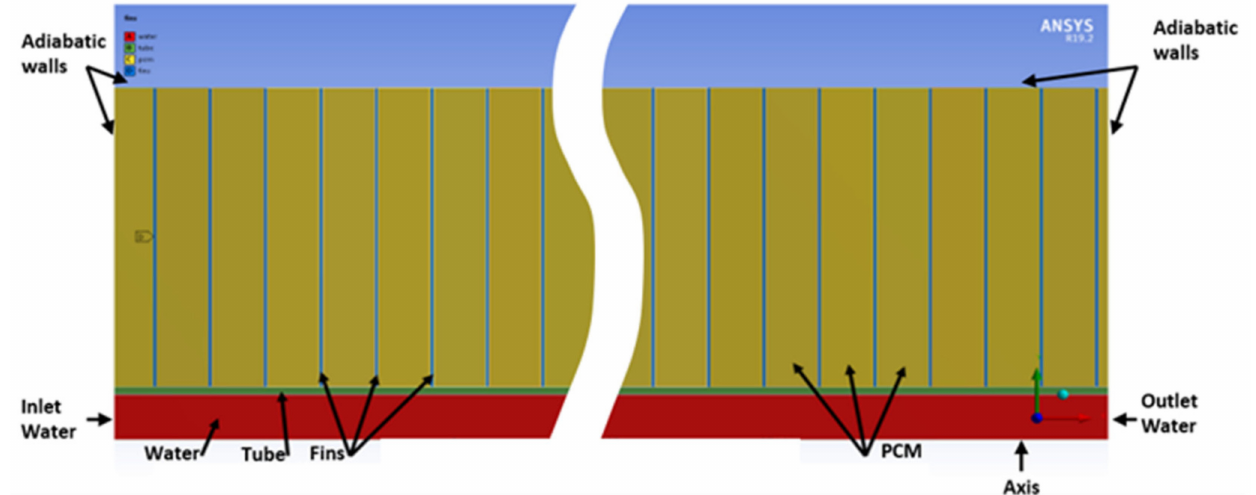
Figure 3. Heat exchanger 2D geometry—water (red), tube (green), fins (blue), PCM (olive green).